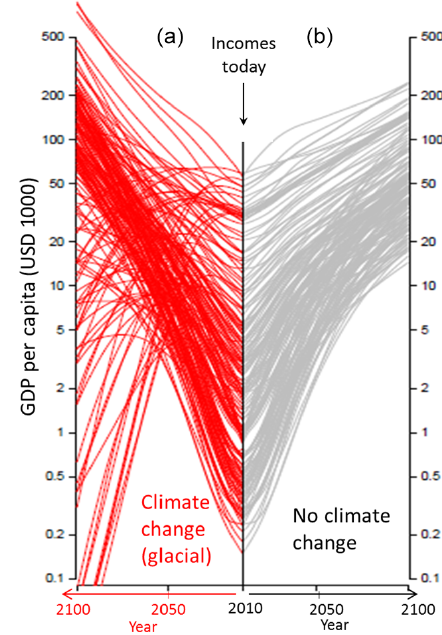
Figure 5. Country-level average income projections with and with- out temperature effects of a “glacial’’ climate change. Projections to 2100 according to the SSP5 scenario, assuming high baseline growth and fast income convergence. The center is 2010, and each line is a projection of national income. On the right (grey) are in- comes under baseline SSP5 assumptions, and on the left (red) are incomes accounting for nonlinear effects of projected cooling on GDP